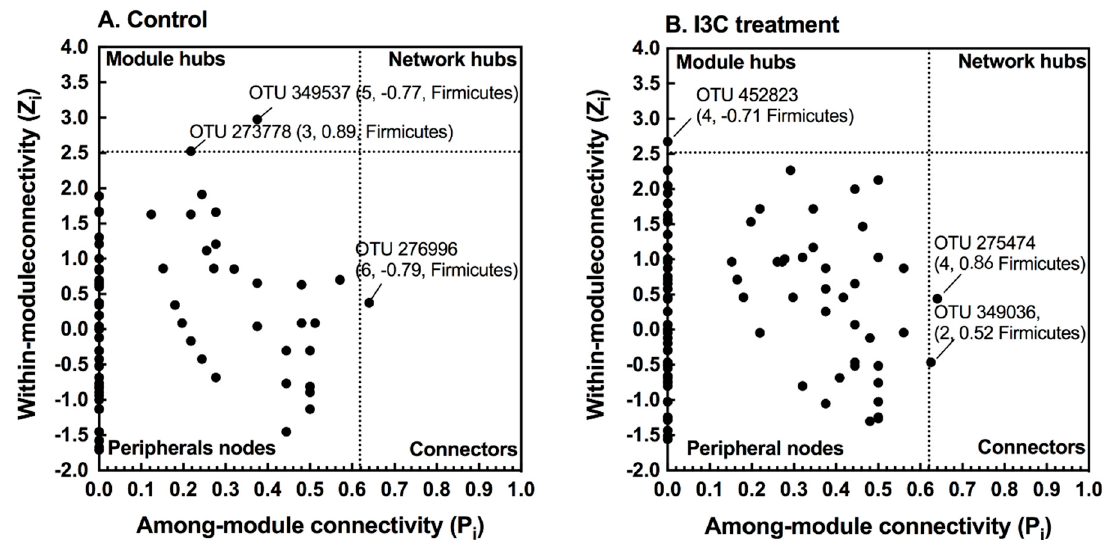
Figure 3. Z-P plot showing the distribution of OTUs based on their topological roles. I3C treatment greatly altered the network structure and topological roles of individual OTUs and key microbial populations. ( A ) Control; ( B ) I3C treatment. The topological role of each OTU was determined according to the scatter plot of within-module connectivity (Zi) and among-module connectivity (Pi). The module hubs and connectors are labeled with OTU numbers. In parentheses are the module number, module membership, and phylogenetic associations.